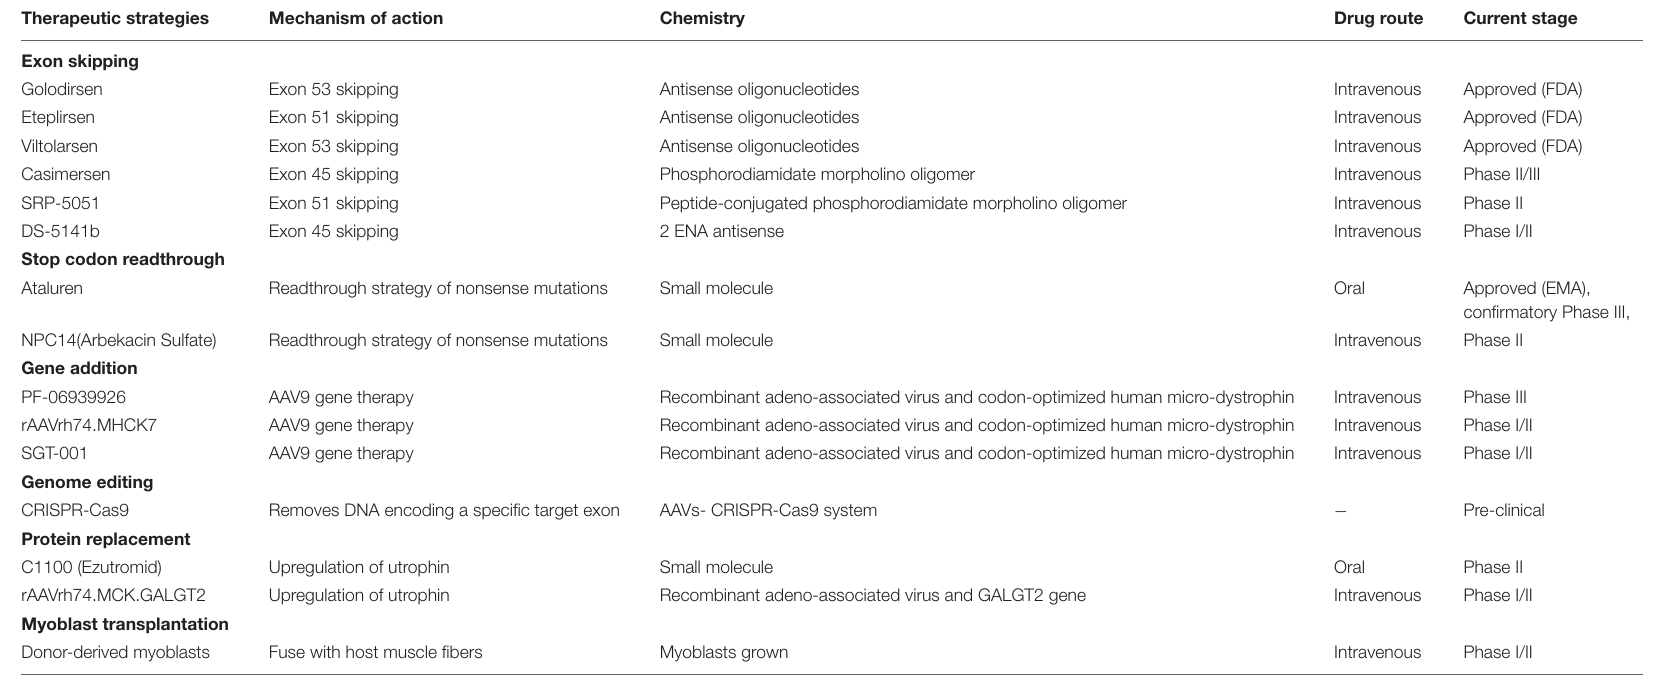
TABLE 1 | Status of the current therapeutic strategies targeting the primary defect of Duchenne muscular dystrophy (https://www.clinicaltrials.gov). Therapeutic